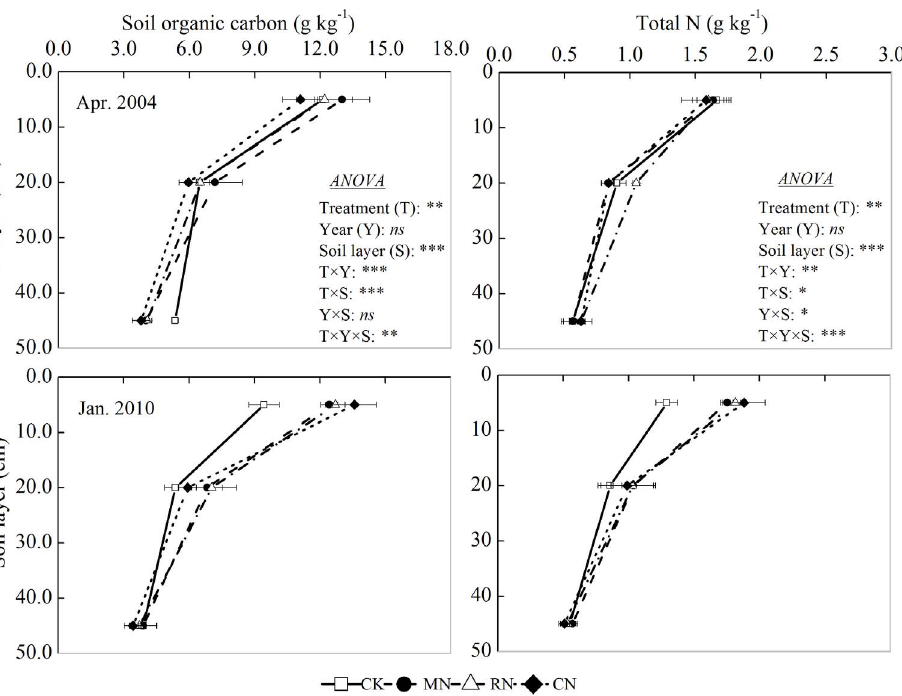
Figure 2. The distribution of soil organic carbon and total N concentrations in the soil profile with different N treatments in the year-round greenhouse tomato planting system in Shouguang, northern China. Note: *, ** and *** indicate significant differences at P , 0.05, P , 0.01 and P , 0.001, ns denotes no significant difference.